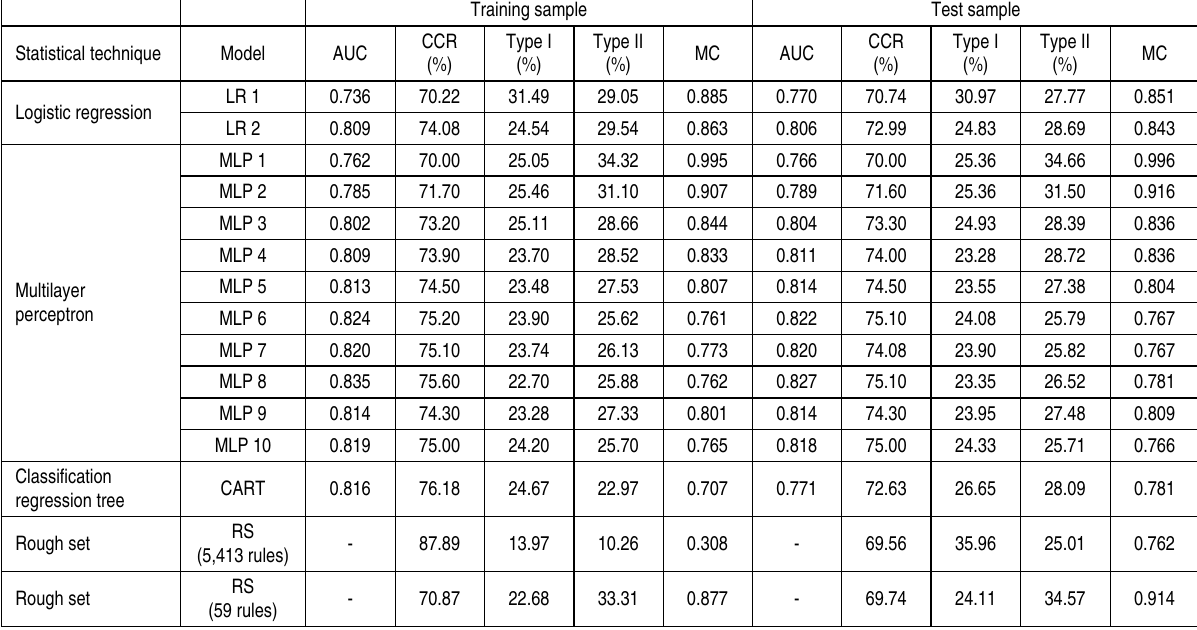
Table 5. AUC, correct classification rate, type I-II errors, and misclassification costs